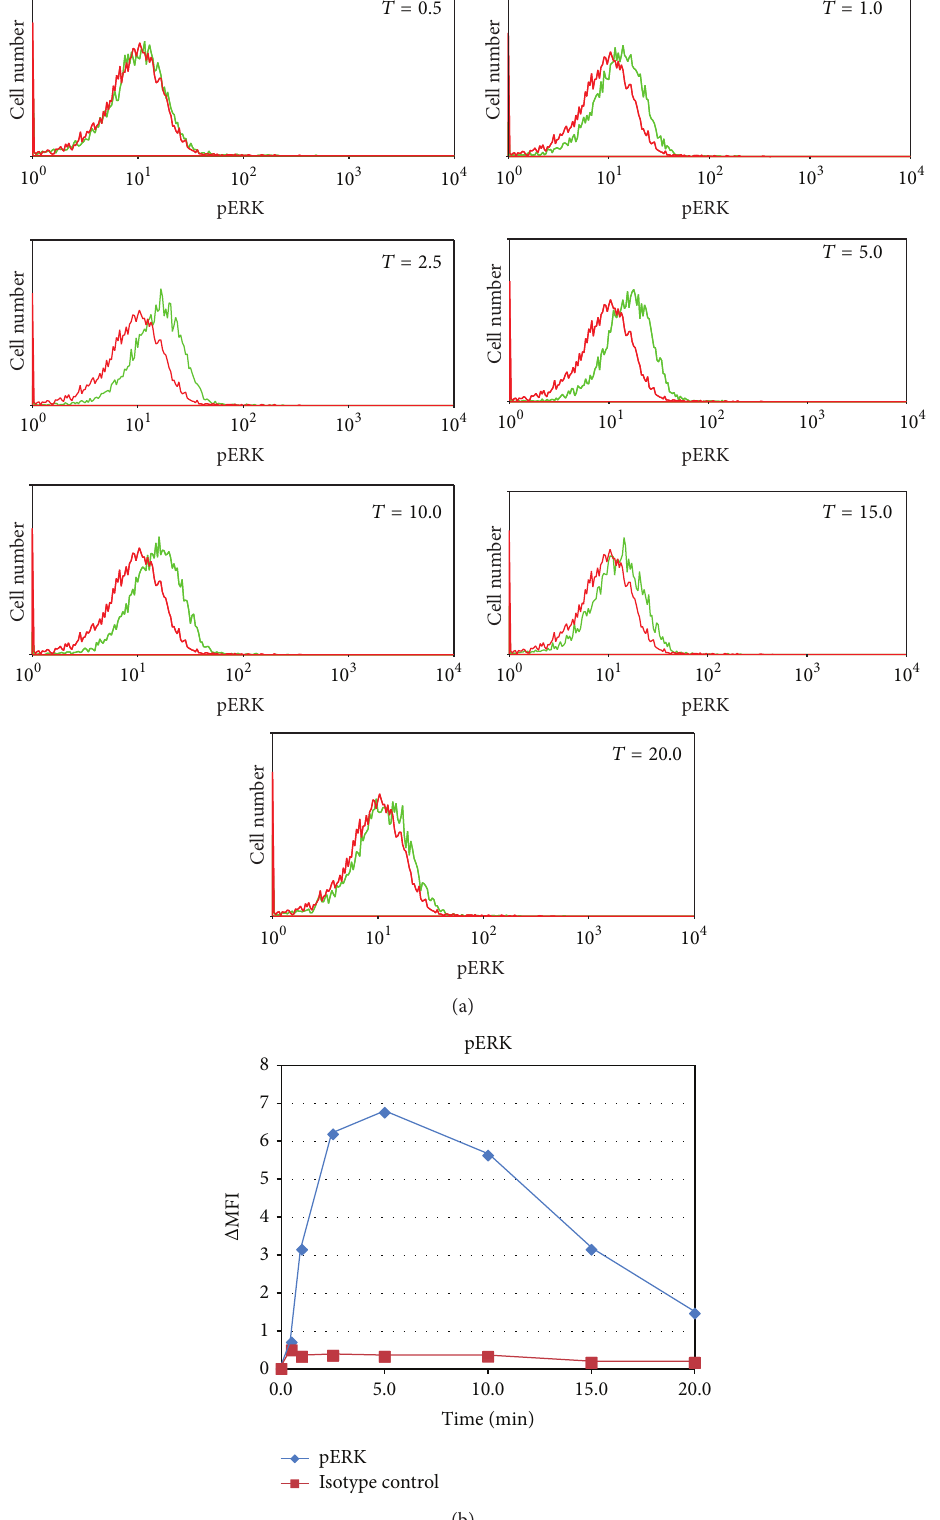
Figure 1: Time course of pERK in WEHI-231 B cells after stimulation of the BCR with anti-mu as determined with phosphoflow cytometry. (a) Histograms at various times for pERK (green, light hue) and isotype control (red, dark hue). (b) Change in MFI (as calculated from the histograms in (a) as a function of time after BCR